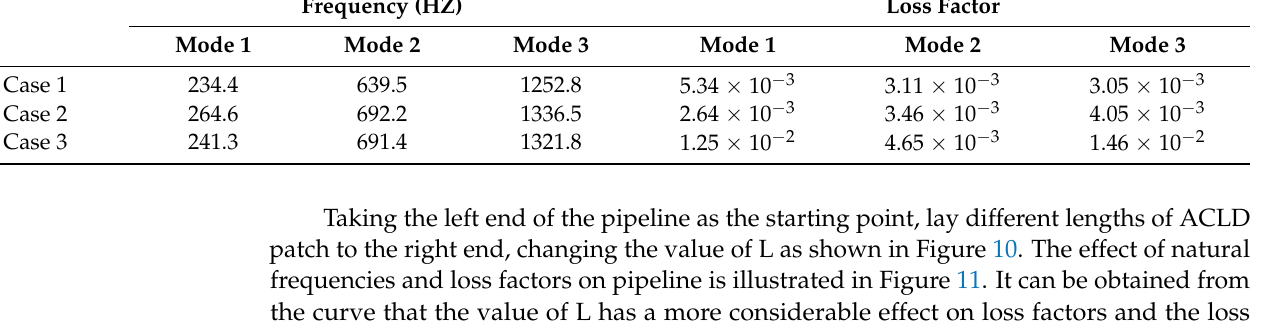
Figure 9. Schematic diagram of pipeline in case 3. Table 5. Natural frequency and loss factor of pipeline in three cases.